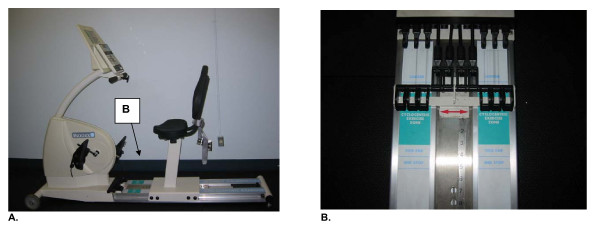
A. The Biodex Cyclocentric Semi-Recumbent Cycle has a wide-based seat with an optional seat belt. The seat is released by a handle located below the front panel allowing it to slide back along the track when the subject pushes forward on the pedal. B. Ten tensioning cords (10 lbs per cord) located at the base of the stationary bicycle provided progressive levels of loading. In this photograph, four of the cords are engaged for a total load of 40 lbs resistance. The arrows point to a location within the "cyclocentric exercise zone" when the seat is positioned for optimal lower limb range of motion during resisted cycling.